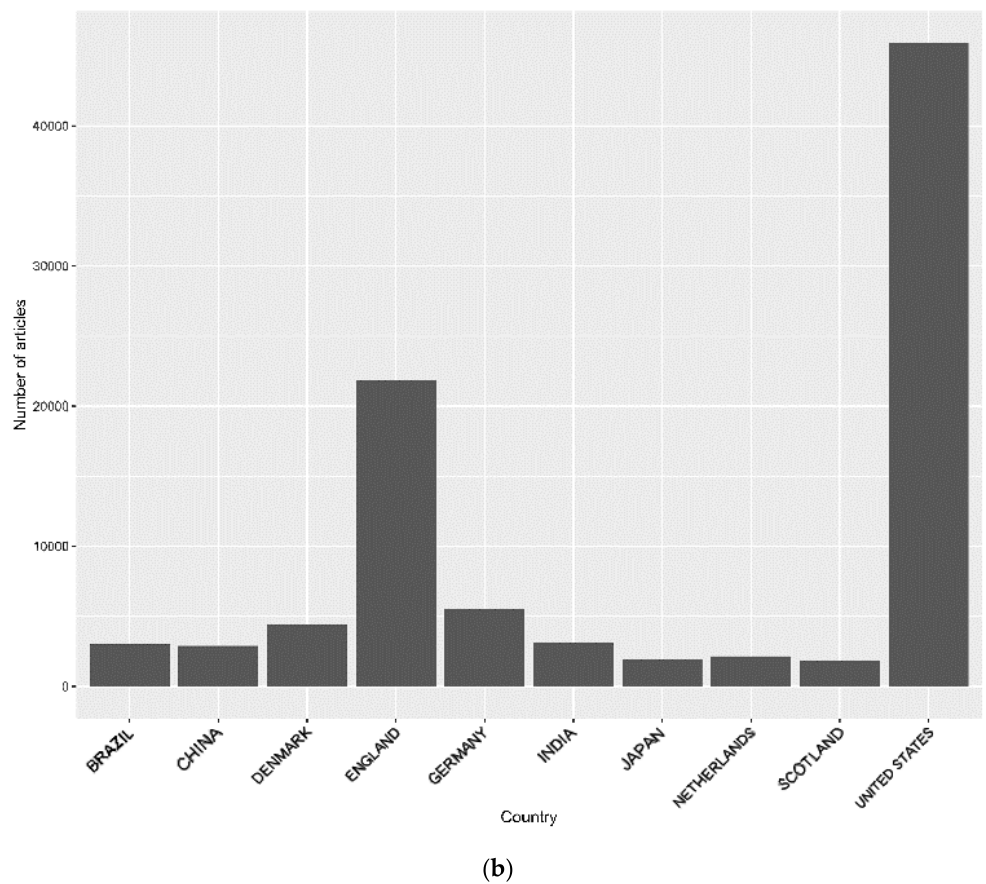
Figure 2. Most productive countries with respect to number of dental publications, 2009 to 2019. ( a ) Based on the count of the corresponding authors from each country for both single country publications (SCP) and multiple country publications (MCP). ( b ) Based on the count of articles published for each country.